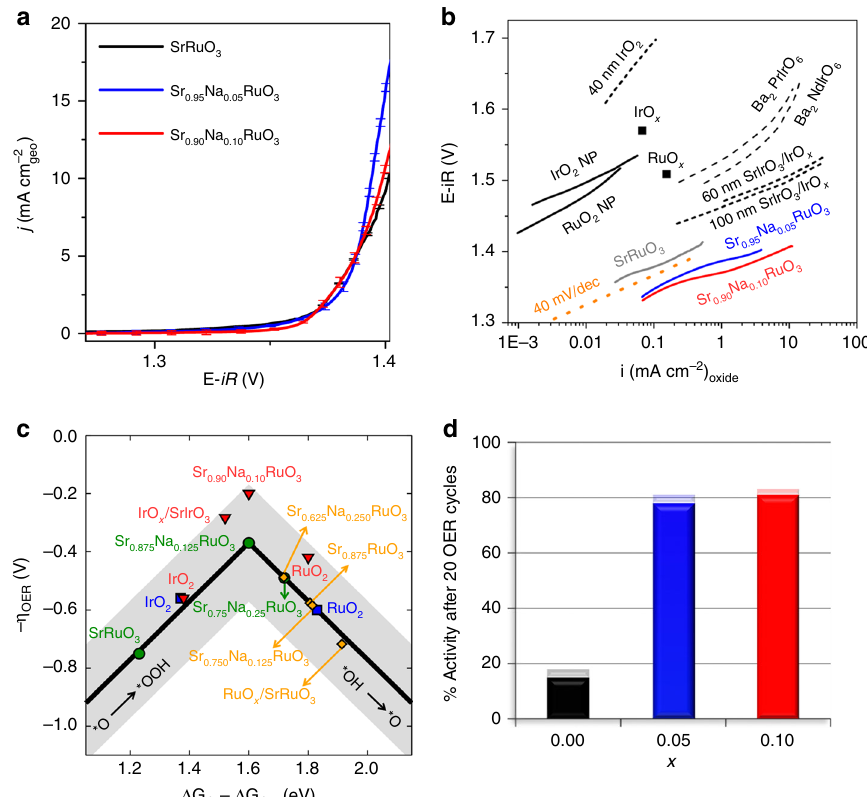
Fig. 2 OER activity and durability. a Current densities ( j ) curves (SrRuO 3 (black), Sr 0.95 Na 0.05 RuO 3 (blue) and Sr 0.90 Na 0.10 RuO 3 (red)) including the relative standard deviation (RSD). b TAFEL plots compared to the intrinsic activities of selected OER catalysts in acidic media. The data are taken from ref. 14,15 . We represent the normalization using A S . A line corresponding to a Tafel slope of 40 mA/decade (magenta dotted line) serves as a guide to the eye. c , OER Volcano-type activity plot. Data in green for Sr 1- x Na x RuO 3 , orange (partially dissolved perovskites, see also Supplementary Fig. 14c) and RuO 2 (blue) are from this study, data for IrO 2 (blue) is from ref. 60 . Data in red come from experiments (this work; refs. 15,30 ), following the approach of Jaramillo and co- workers 36 , which correlates DFT-calculated descriptors with experimental overpotentials at 1 mA/cm 2 oxide . Error bands of ± 0.2 V surround the lines to account for the accuracy of the calculations. d Percentage catalytic activity of Sr 1- x Na x RuO 3 after 20 cycles with respect to the initial activity, including RSD as shadow